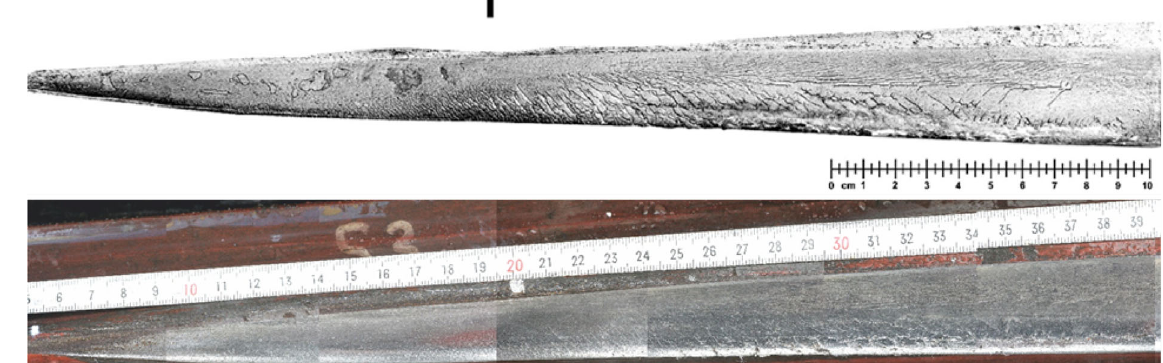
Fig. 3 MPI (above) and HRPI (below) images of the rolling surface on a frog nose after 33 Mt